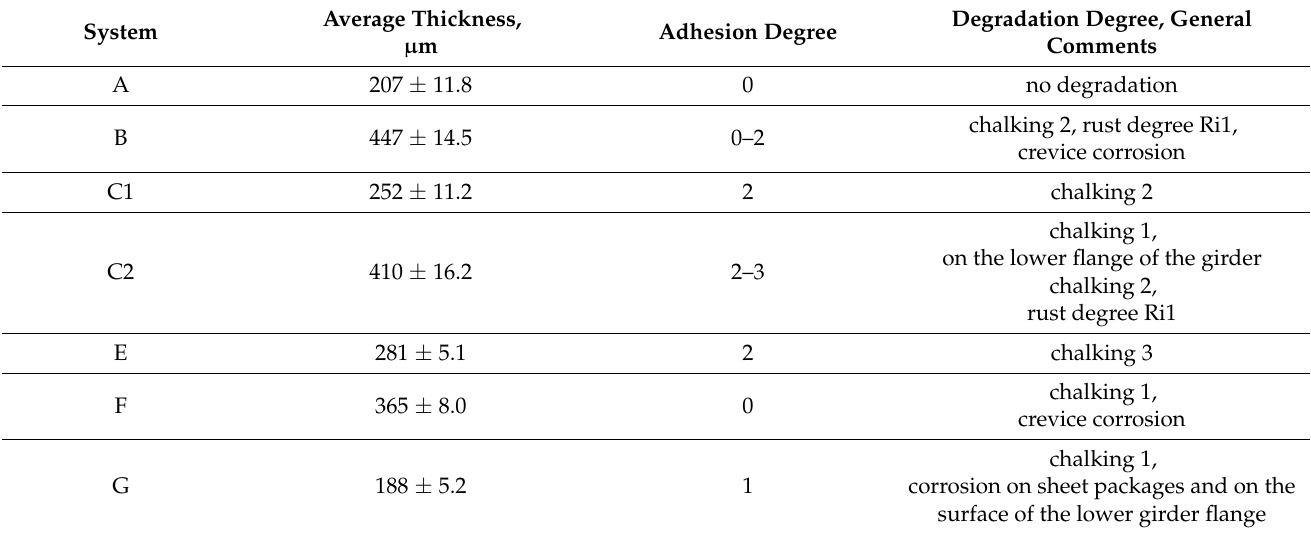
Table 4. The results of the assessment of coatings on objects according to ISO 4628: 2003, ISO 16276-2: 2007 and ISO 19840: